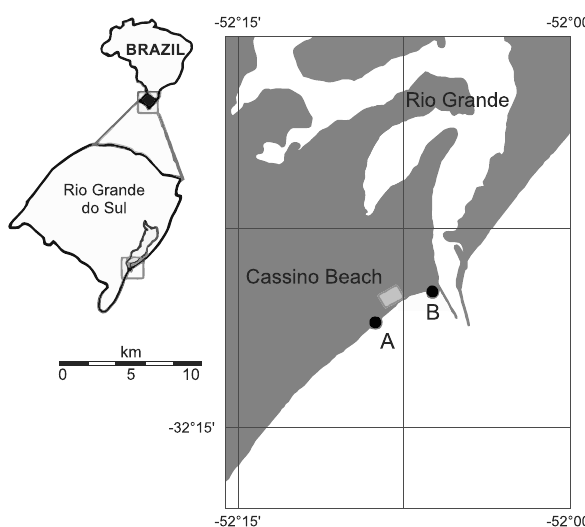
Figure 3. Geographic location of the study area, Cassino Beach, in detail, with the two sampling sites (A and B). Modified by the au- thors from http://www.aquarius.geomar.de (Online